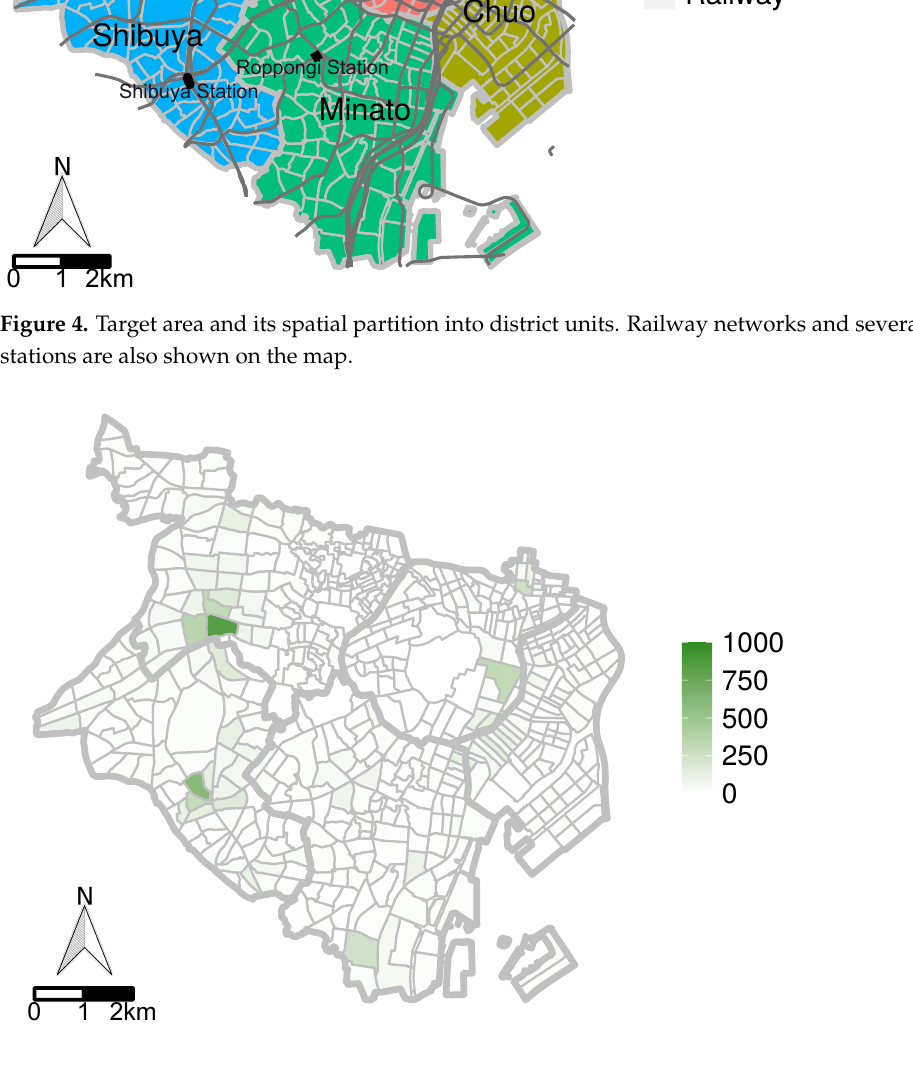
Figure 5. Choropleth map showing non-intrusive theft occurrences in the target